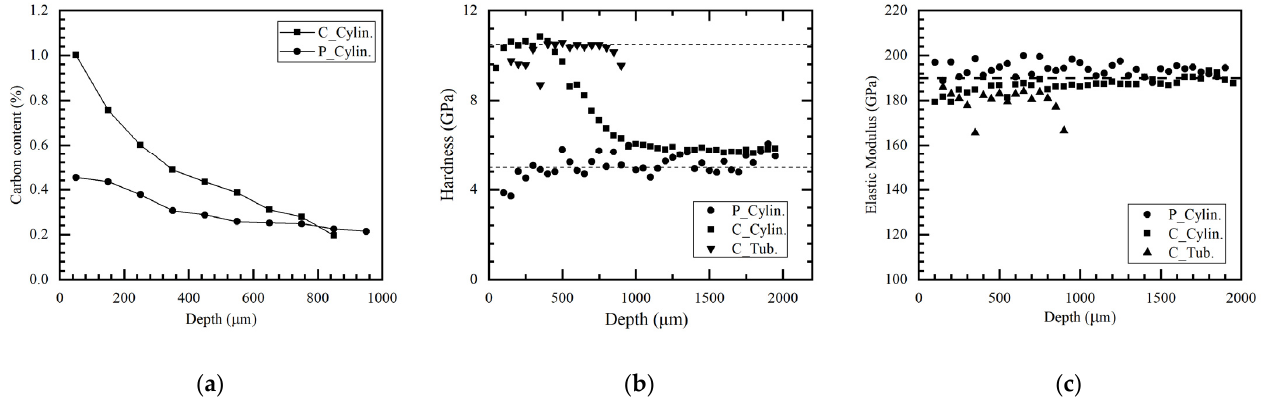
Figure 2. ( a ) Distributions of carbon content in the solid specimens and ( b ) distributions of hardness and ( c ) elastic modulus obtained from the nanoindentation tests in three types of specimens.